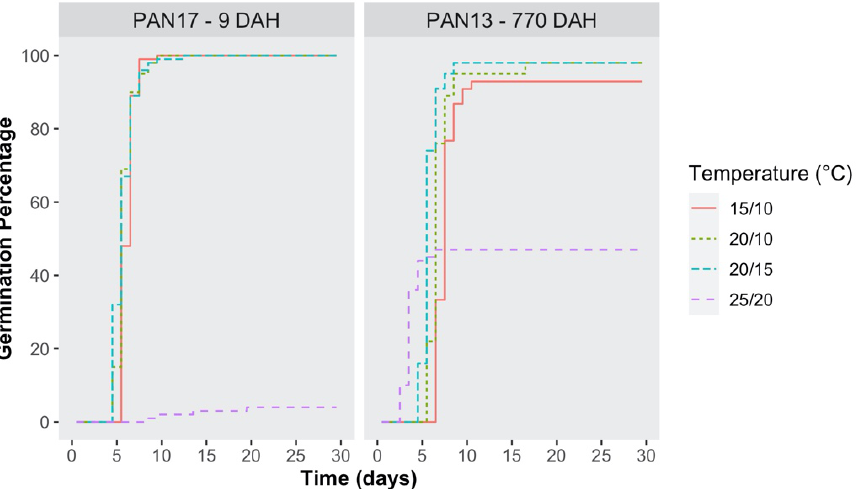
Figure 5. Kaplan–Meier estimates of germination curves for seeds of the S. hicesiae PAN seed source at two seed ages (9 and 770 days after harvest = DAH), incubated for 30 days under light/dark conditions (L/D), at four alternating temperatures (15/10 °C, 20/10 °C, 20/15 °C, and 25/20 °C), and expressed as the percentage of viable seeds.